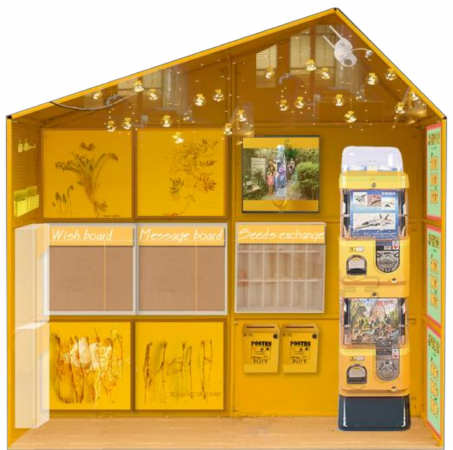
Figure 1. The design of the seed relay